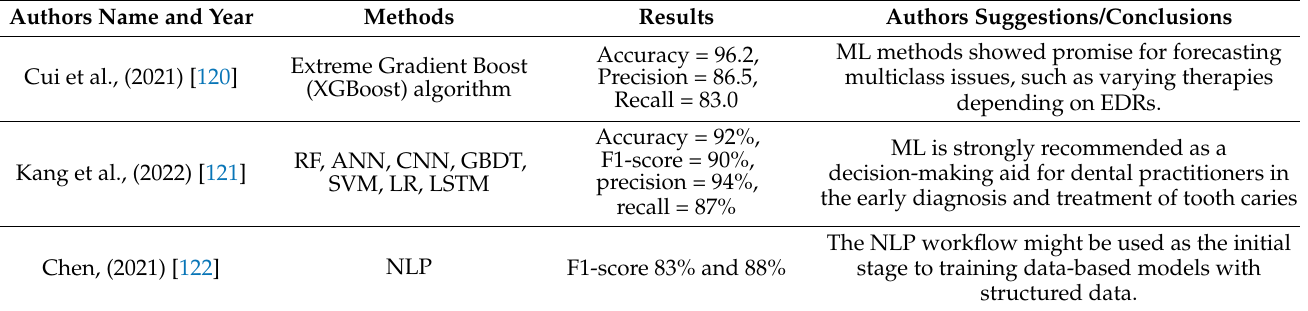
Table 9. EDR selected